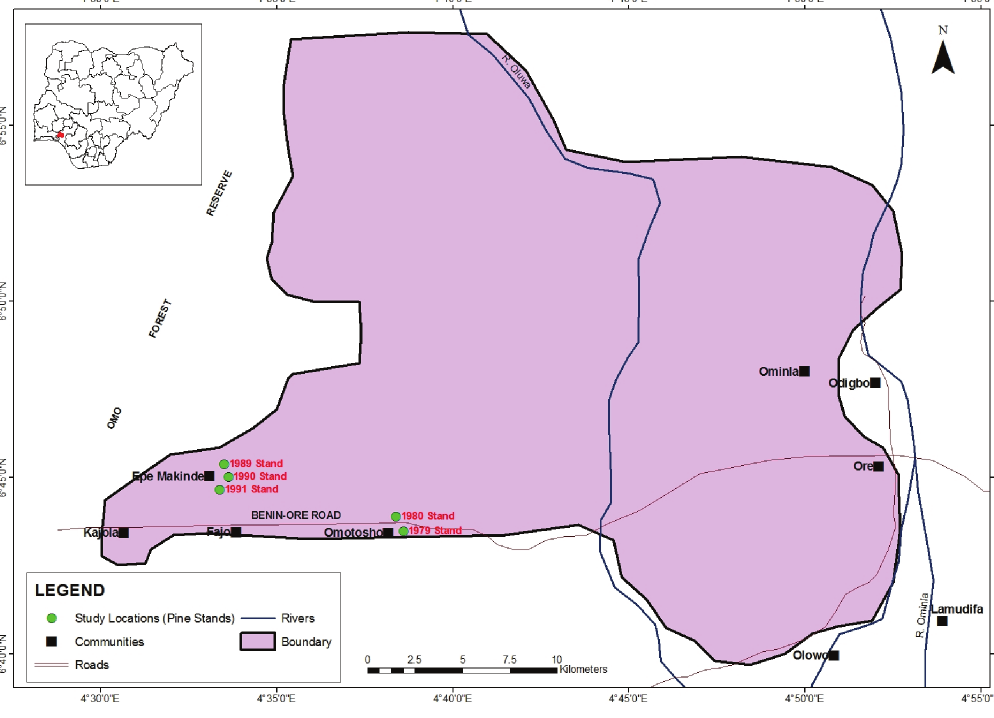
FIGURE 1. Map of Oluwa Forest Reserve showing the study